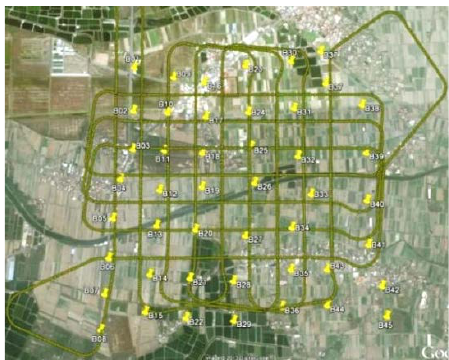
Figure 4. UAS flight trajectory and distribution of control points